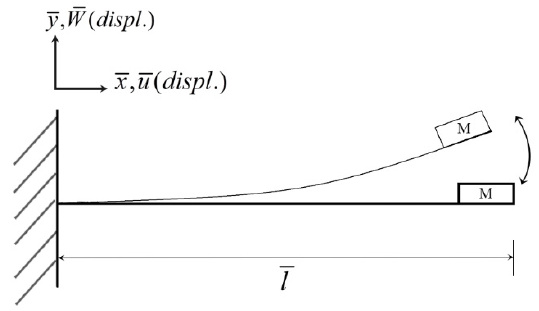
Figure 4. Beam Figure 4. Beam coordinates.